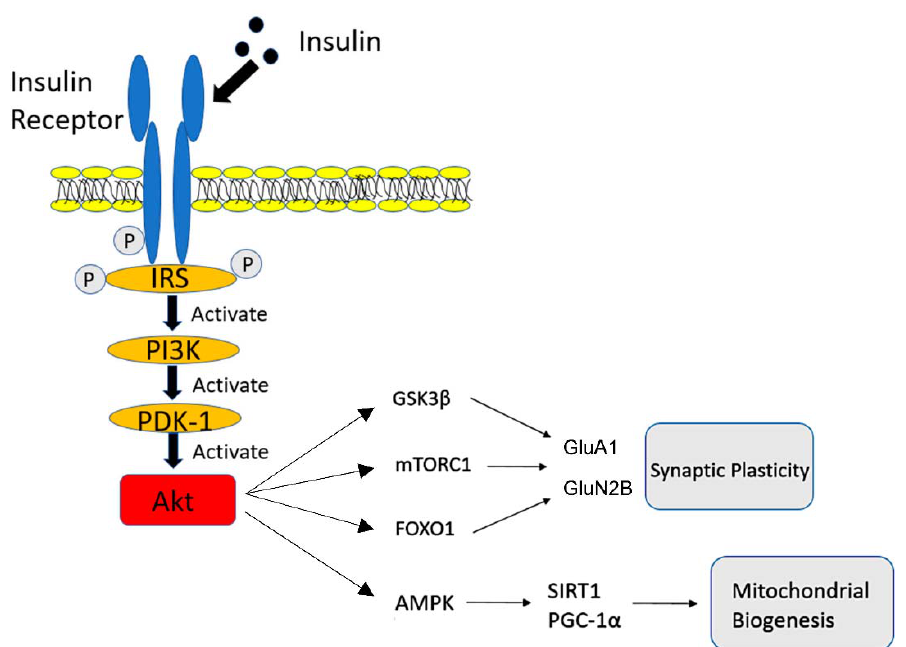
Figure 1. Implications of insulin in cognitive performance. Once an insulin receptor is activated, phosphorylation of the insulin receptor substrate (IRS) is triggered. Then, phosphoinositide 3-kinase (PI3K) and phosphoinositide-dependent protein kinase-1 (PDK-1) are activated, resulting in the activation of protein kinase B (Akt). Activated Akt promotes several downstream cascades and influences synaptic plasticity as well as mitochondrial dysfunction.